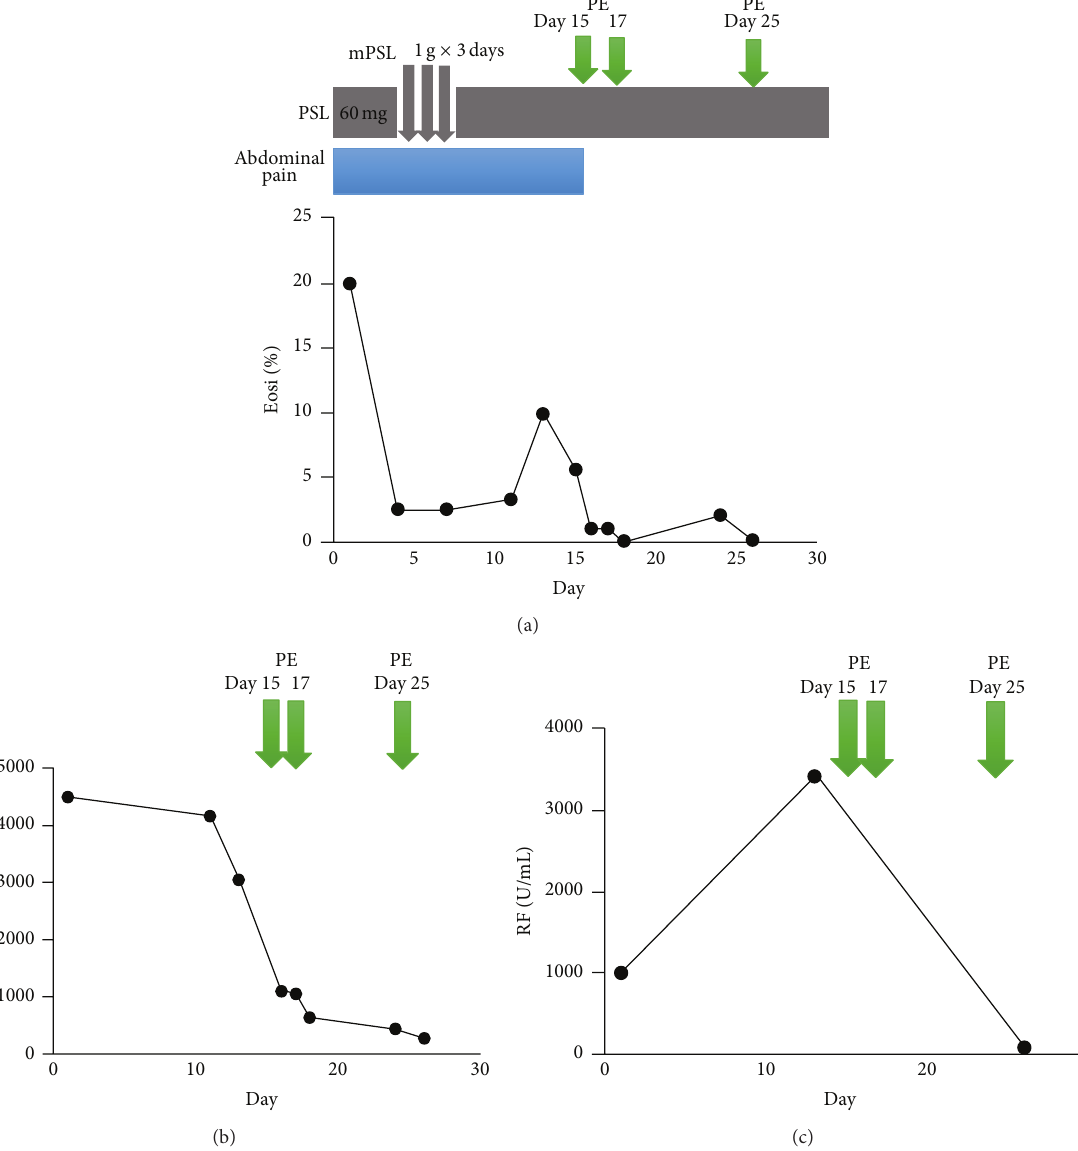
Figure 2: Clinical course of the present case. (a) Treatment timing and trends in eosinophil count. (b), (c) The effect of plasma exchange on IgE and RF. PSL, prednisolone; Eosi, eosinophil; RF, rheumatoid